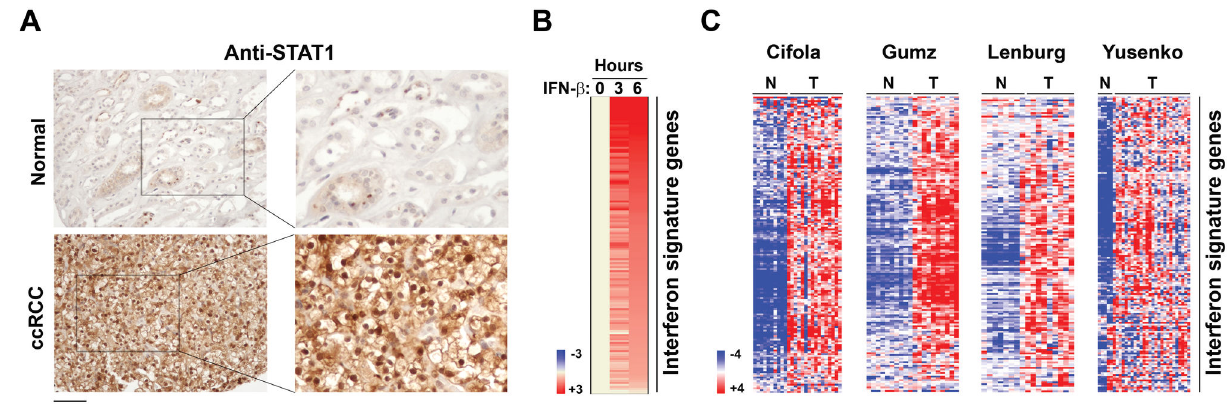
Figure 3. An IFN signature in ccRCC. (a) Immuno-histochemical staining showing robust nuclear STAT1 signal in ccRCC samples, but not in normal kidney tissue. (b) Heatmap showing expression of IFN signature genes after IFN stimulation of murine embryo fibroblasts. Heat bar = fold-change (log scale). Expression levels of untreated cells were arbitrarily set to 1 (beige). (c) 2 Heatmaps showing expression of IFN signature genes in each of the four indicated studies. N = normal, T = tumor. Heat bar = expression levels (log scale). 2 doi: